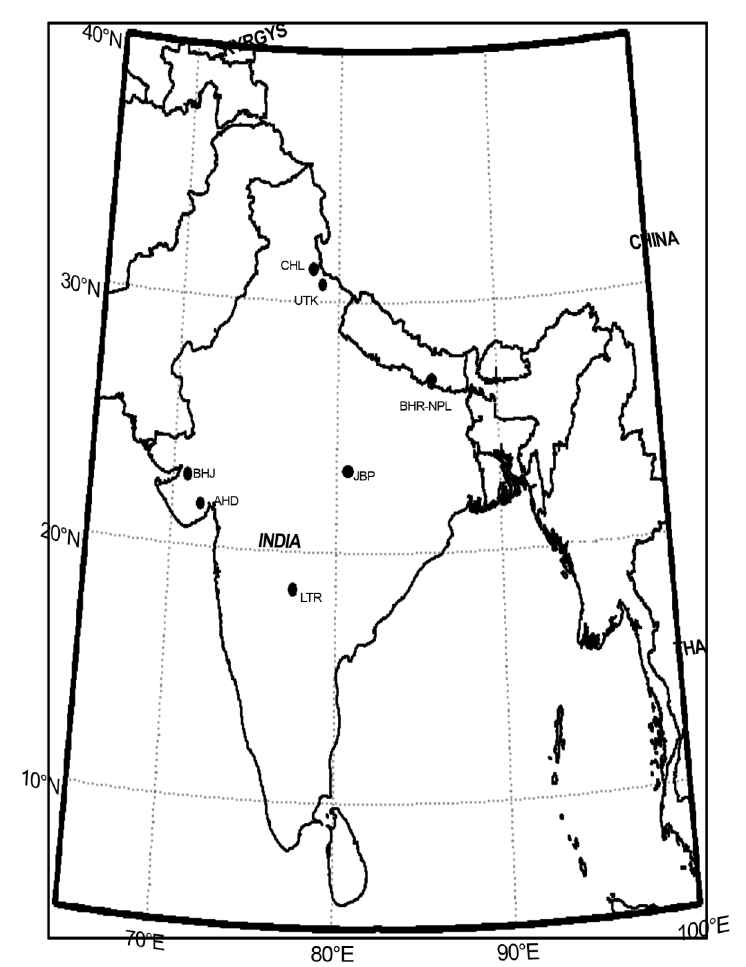
Fig. 1. Map of India showing the locations of three major earthquakes (solid circles). Also shown is the loca- tion of ionospheric station Ahmedabad (AHD).